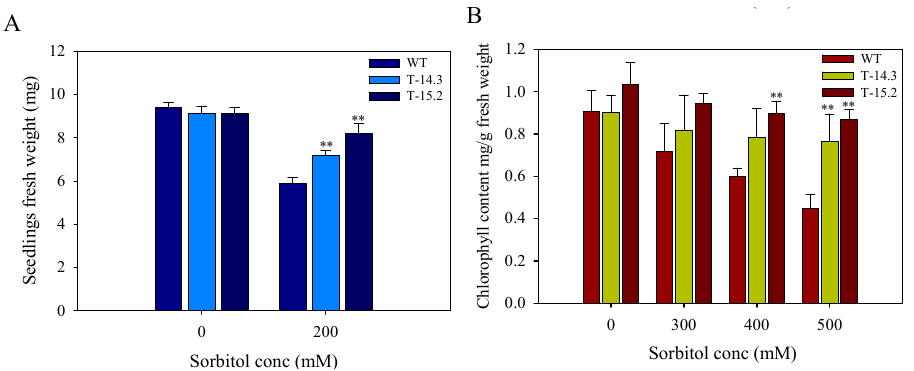
Figure 8. Seedling growth of WT and AnnAt8 transgenic tobacco plants under osmotic stress. ( A ) Seedlings on day 15 after transfer on half strength MS medium; ( B , C ) seedlings on day 35 and 63, respectively after transfer on half strength MS medium supplemented with 300 mM of sorbitol; ( D ) comparison of root and shoot growth after two months of osmotic stress (300 mM sorbitol). Three replicates were used per treatment and the experiment was repeated thrice.